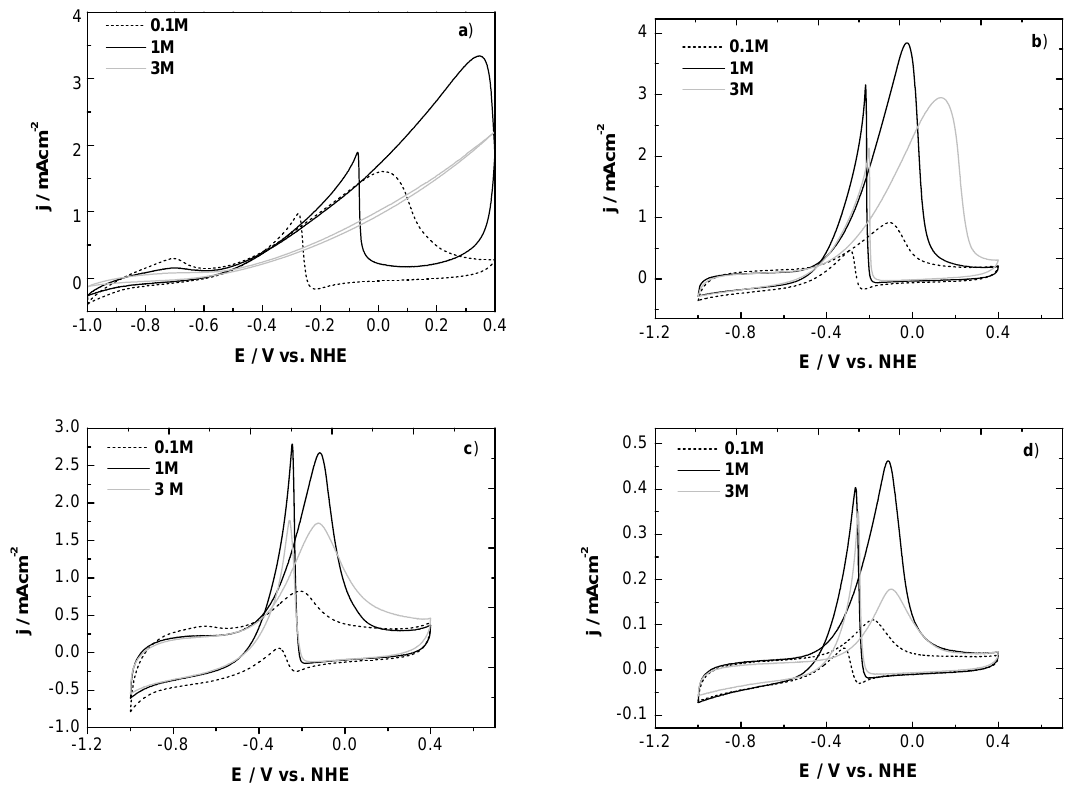
Figure 6. Cyclic voltammograms of Pd catalysts in 1 M KOH at room temperature in three ethanol concentrations: ( a ) commercial Pd/C; ( b ) NR/C; ( c ) NB/C; and ( d ) NP/C.